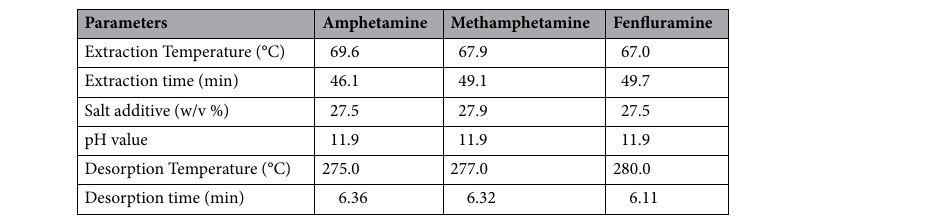
Table 1. Optimal conditions of extraction and thermal desorption parameters of amphetamine compounds by the proposed method.